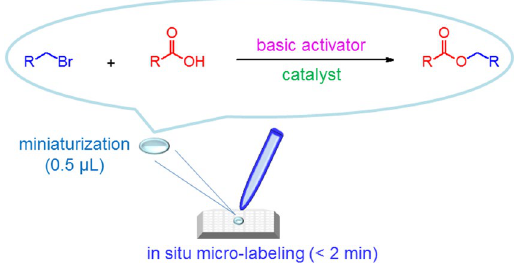
Figure 1. Diagram of micro-labeling of NSAIDs in human